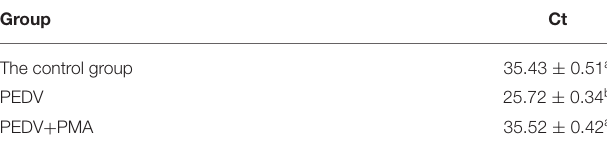
TABLE 2 | The effectiveness of PMA.